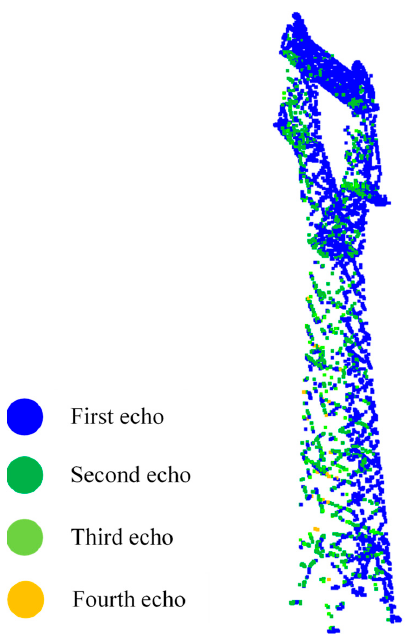
Figure 22. Pylon point cloud from multiple-returns data.